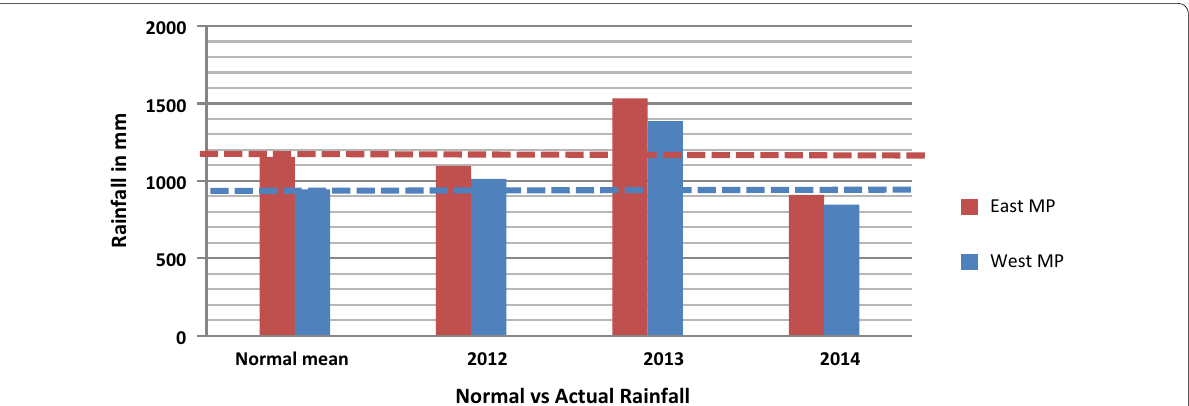
Fig. 24 Rainfall pattern (2012, 2013 and 2014) as compared to normal mean in Madhya Pradesh. The blue and maroon dash line shows that the actual rainfall in the year 2013 in West and East MP, respectively, was much higher than the normal mean rainfall